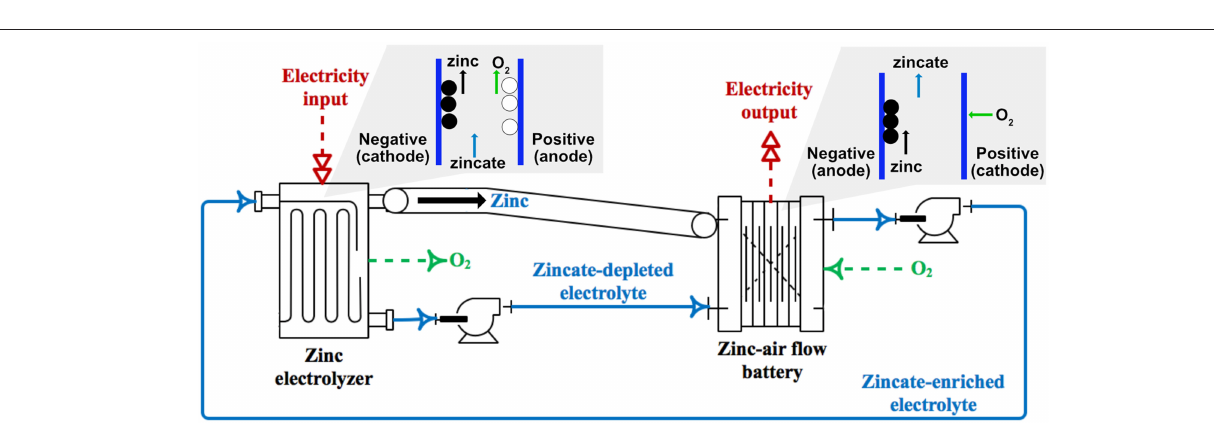
at 55 ◦ C for 10 min. The anode was made of nickel foam (0.5 mm thick with 100 PPI) with an area of 10 cm 2